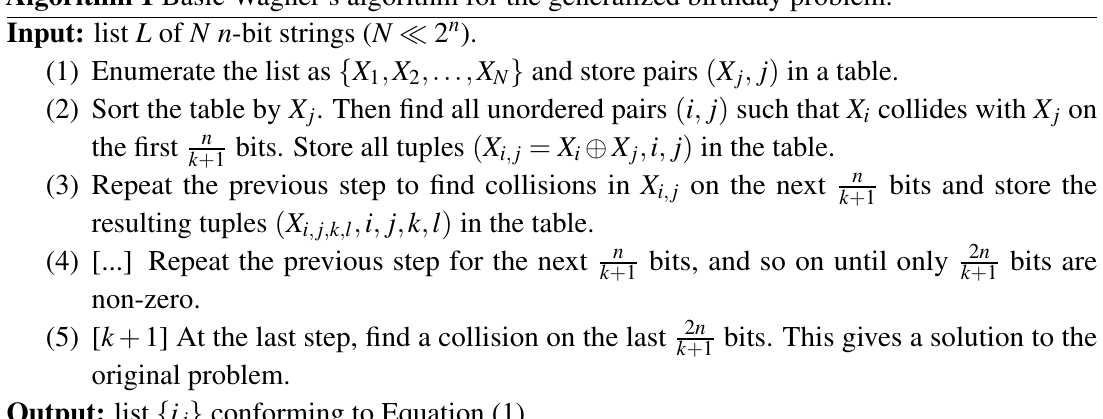
Algorithm 1 Basic Wagner’s algorithm for the generalized birthday